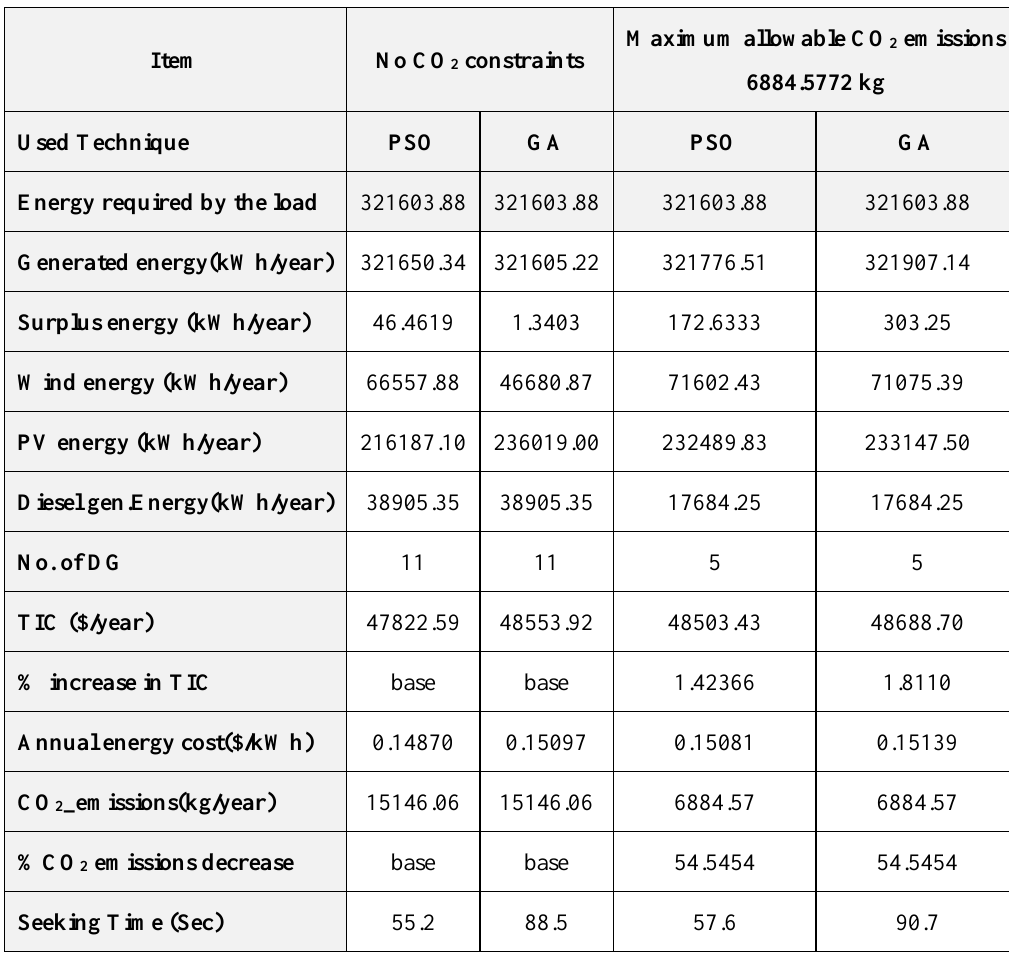
Table 10. Impact of CO2 emissions